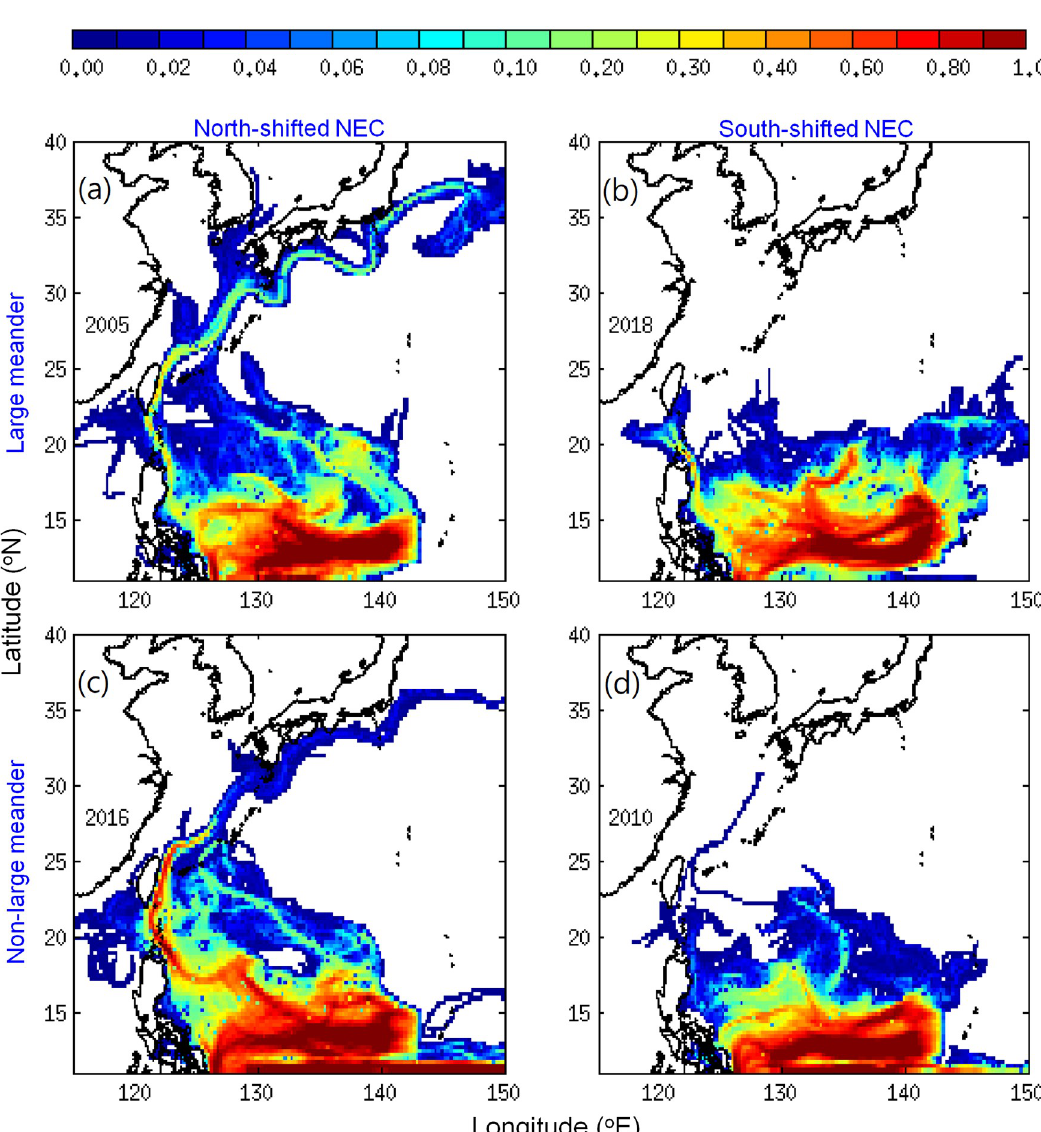
Fig 3. Visitation frequency distributions of v-larvae at the end of January during the early recruitment period in Kuroshio large meander years (a, 2005, b, 2018) and normal years (c, 2016, d, 2010). The unit of visitation frequency was normalized by the total number of released